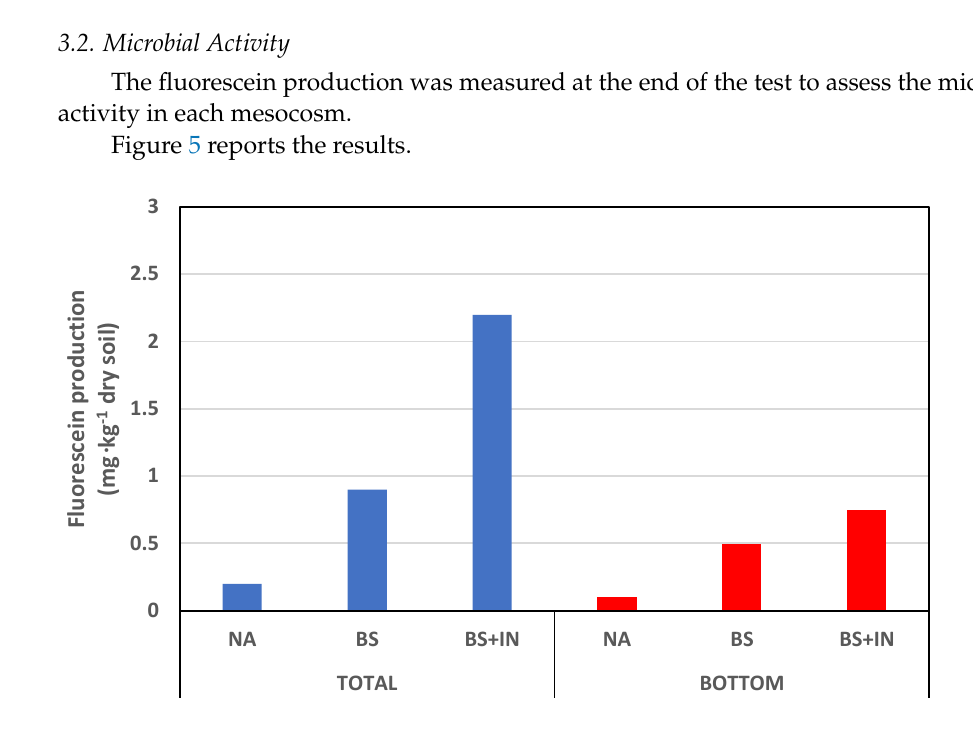
Figure 5. Fluorescein production at t = 228 days for BS and BS + IN, and at t = 193 days for NA.